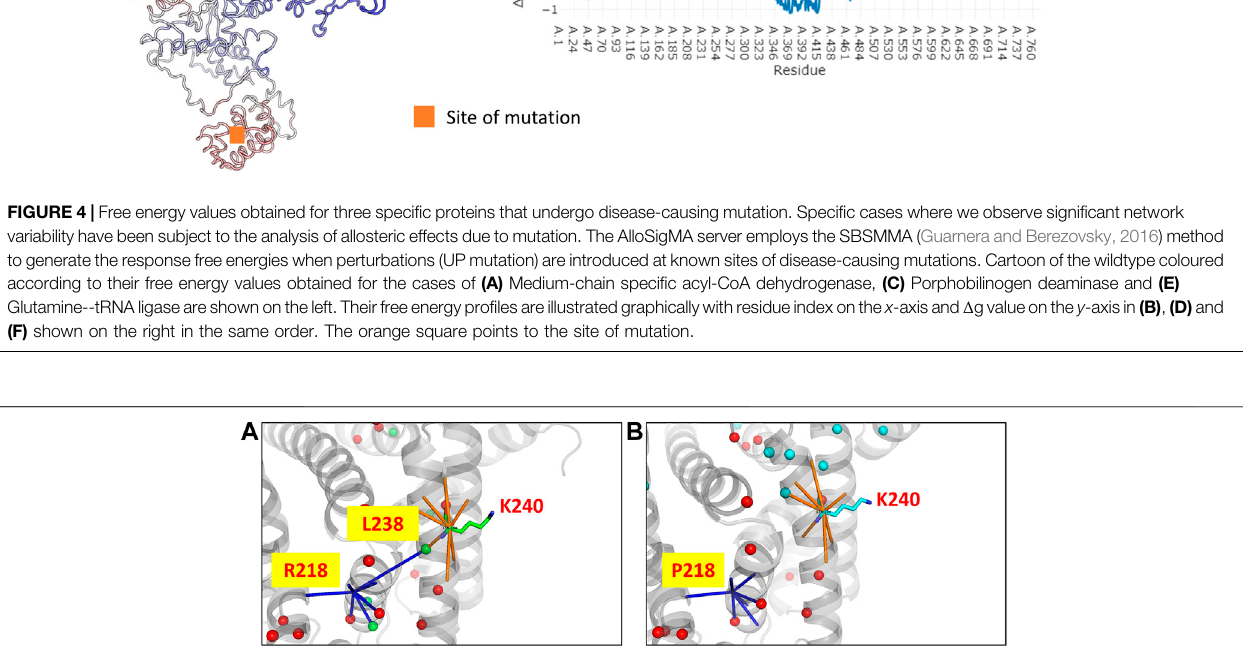
structures (mean RMSD 0.57 Å and mean NDS 0.12) which signi fi es that the mutant structure and network explore diverse conformations with different interconnectivity of residues. The variability observed in protein structural networks is not strongly correlated to the topological structure difference that is used in the